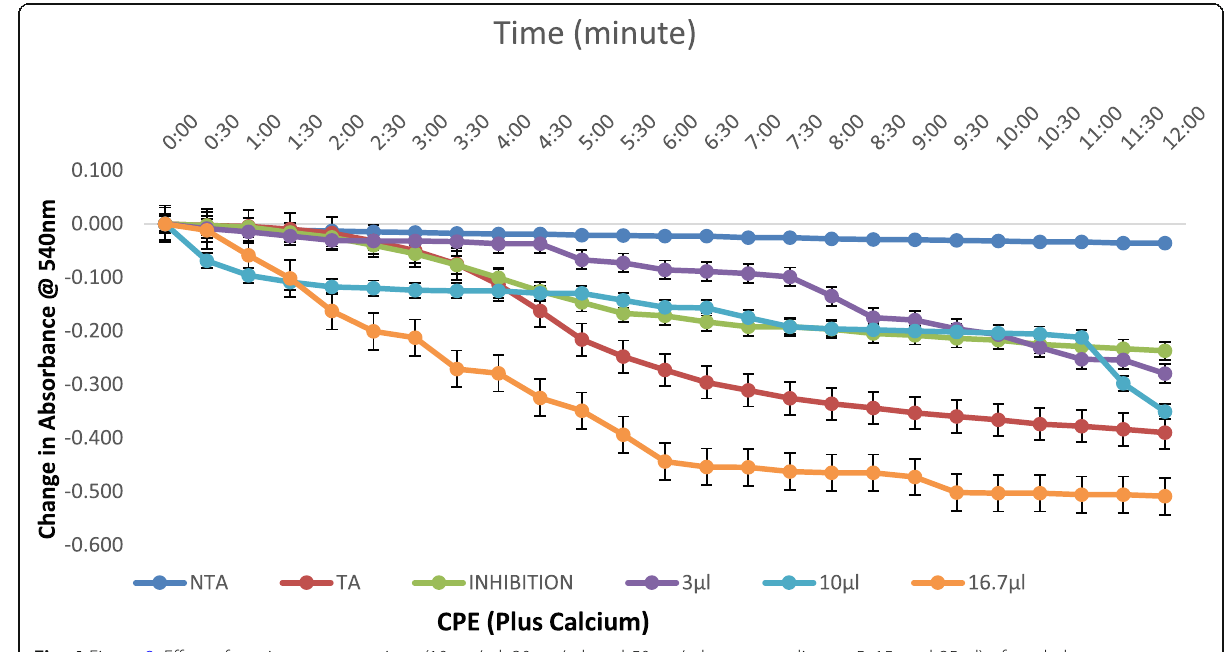
Fig. 4 Figure 2: Effect of varying concentrations (10 μ g/ml, 30 μ g/ml, and 50 μ g/ml corresponding to 5, 15, and 25 μ l) of crude hot water infusion extract of Cassava biogas slurry on rat liver mitochondrial membrane permeability transition pore in the presence of calcium (Ca 2+ ).